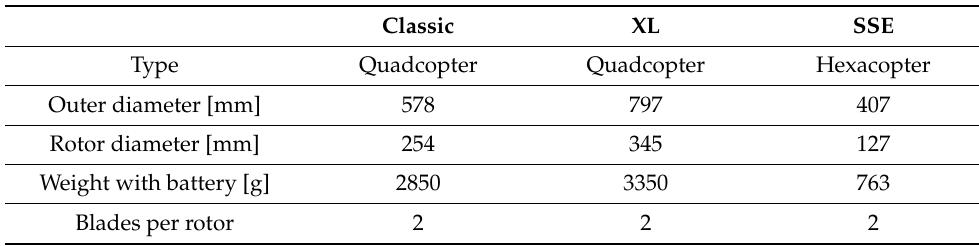
Table 1. Multicopter type, dimensions (mm), and weight (g). (The designation of the multicopters was taken from the